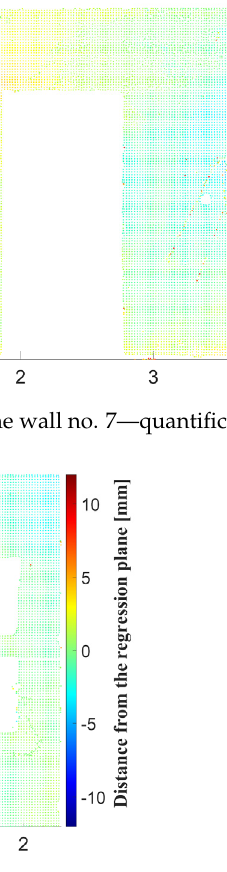
Figure 20. Deviation map, the wall no. 8—quantification of flatness of the wall.